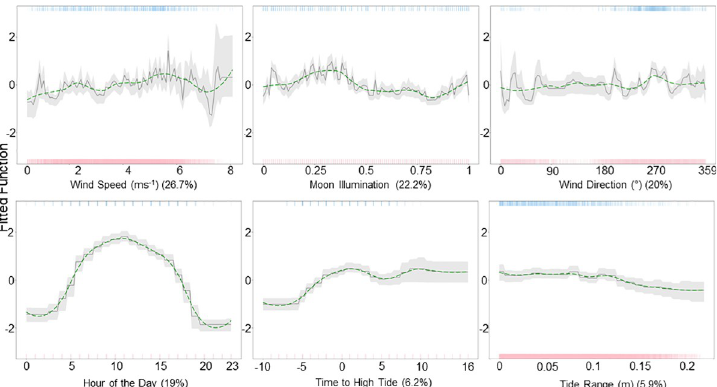
Fig 4. Partial dependency plots for Hanifaru Bay. The effect of each predictor variable on the occurrence of tagged M . alfredi at Hanifaru Bay, while keeping all other variables at their mean. The green dashed line shows locally weighted smoothing (LOESS). Rugs display the distribution of the data for presence (top, blue), and absence (red,